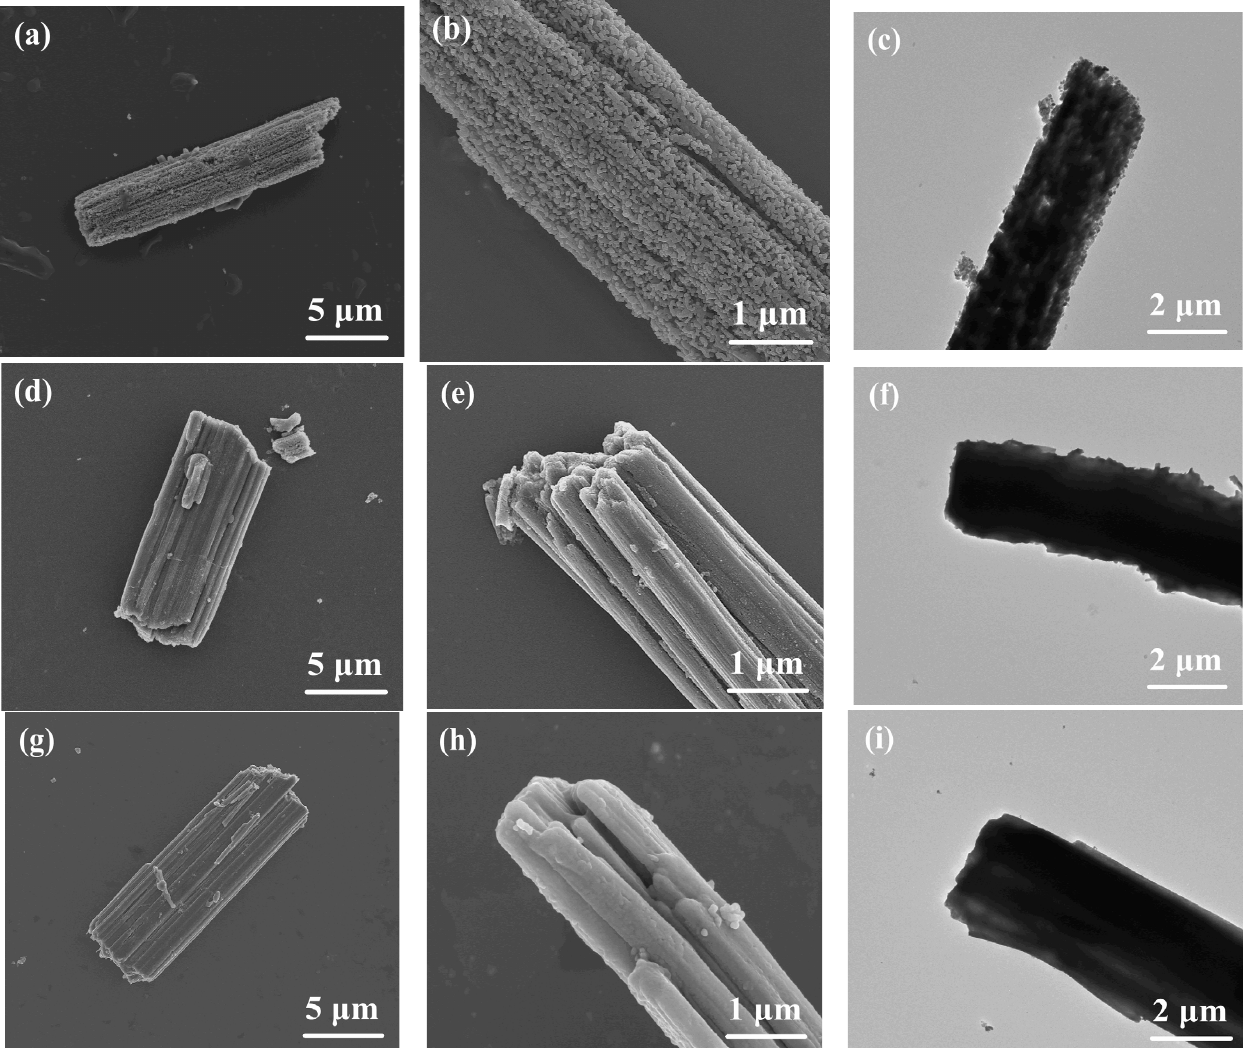
Figure 2. ( a ) Low-, ( b ) high-magnification SEM and ( c ) TEM images of VN. ( d ) Low-, ( e ) high-magnification SEM and ( f ) TEM images of VN/S composite. ( g ) Low-, ( h ) high-magnification SEM and ( i ) TEM images of VN/S@PANI composite.